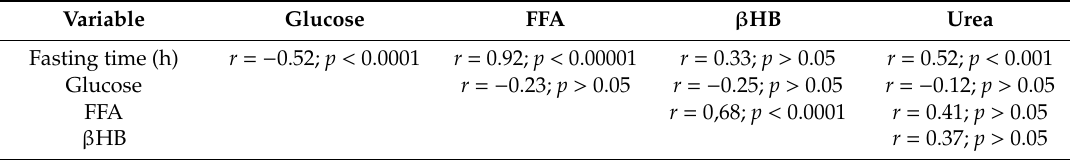
Table 6. Correlation between blood variables and fasting duration during the fasting time. Variable Glucose FFA β HB Urea Fasting time